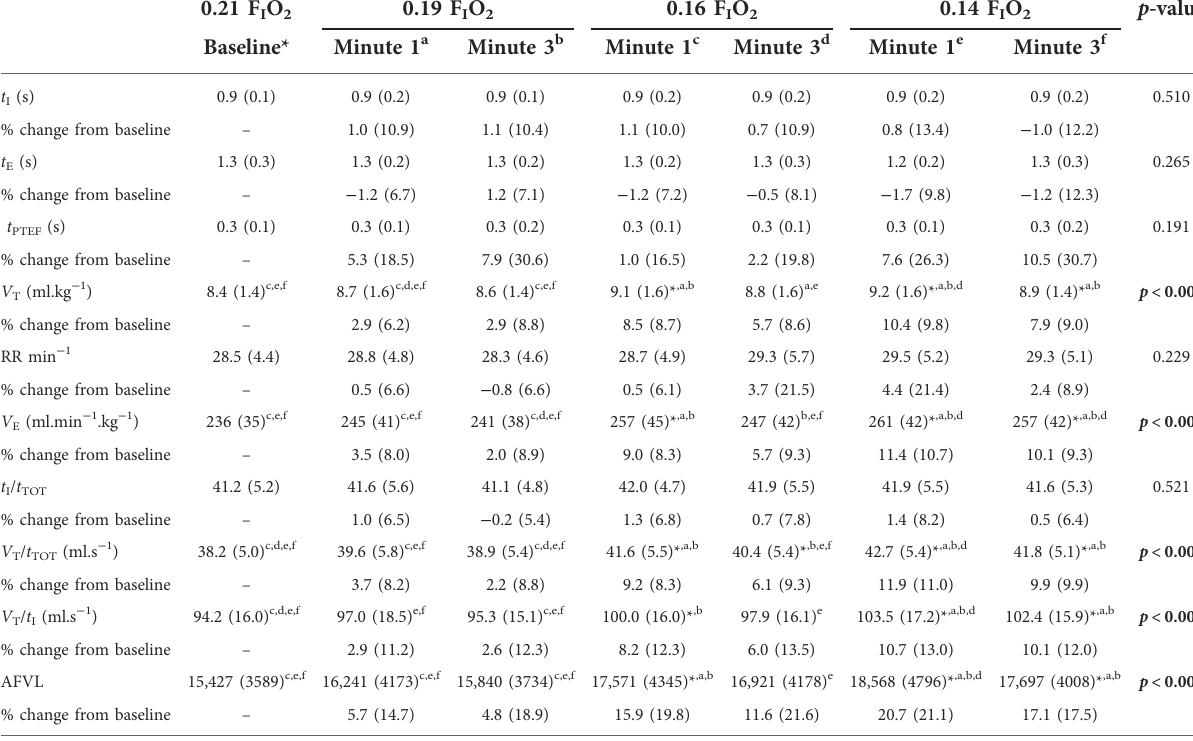
TABLE 2 Tidal breathing measures at baseline and during hypoxic conditions.